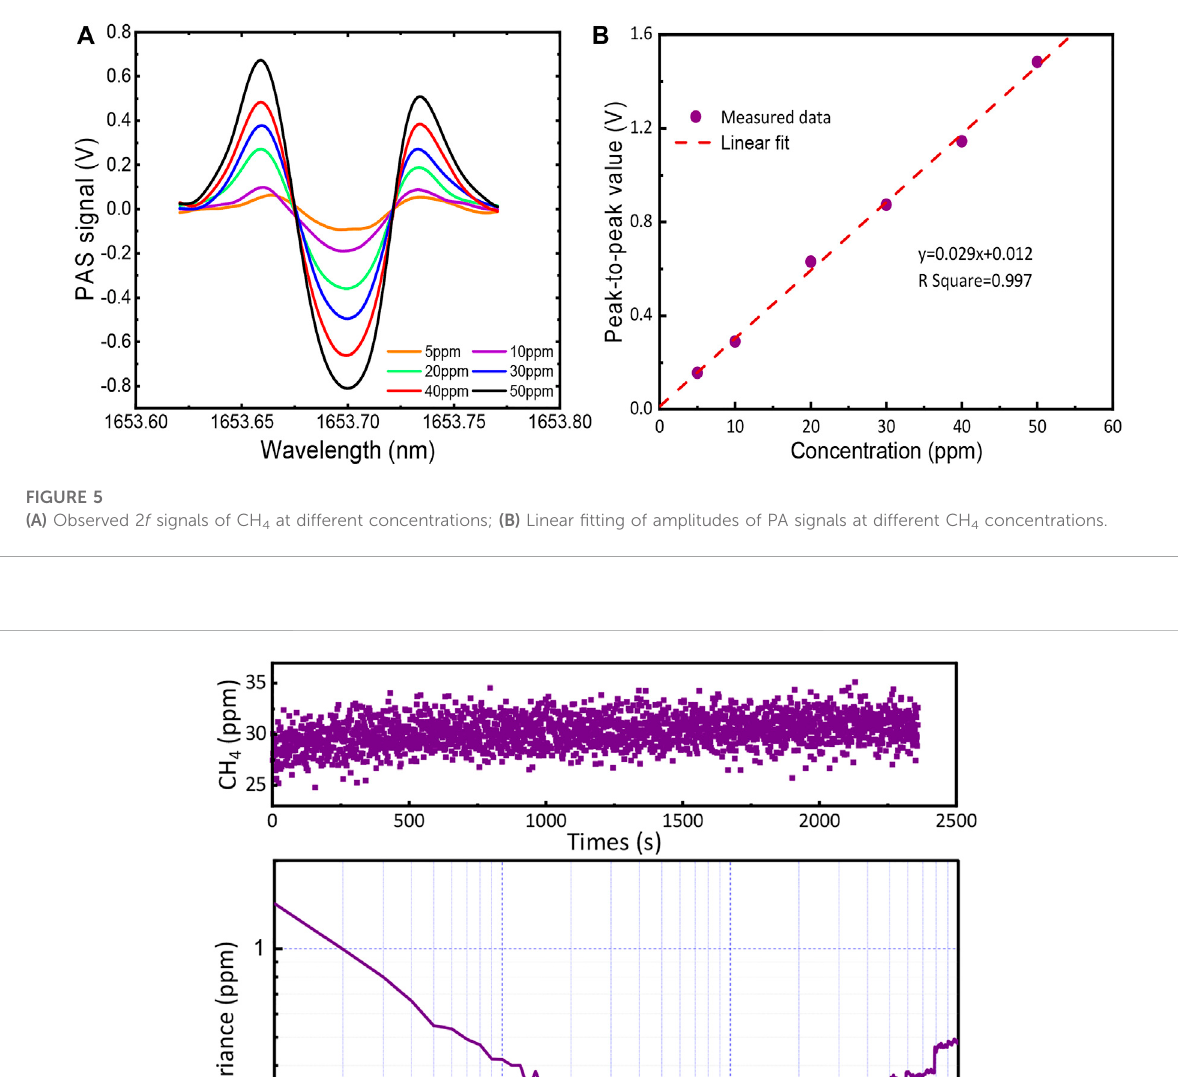
signal of 30 ppm CH 4 was measured for 1 h to assess the detection limitation and stability of the sensor. A total of − 2,400 data points were obtained with a scan frequency of 1 Hz. As shown in Figure 6 (bottom), the Allan variance is a function of the measurement time. The fi gure indicates that the